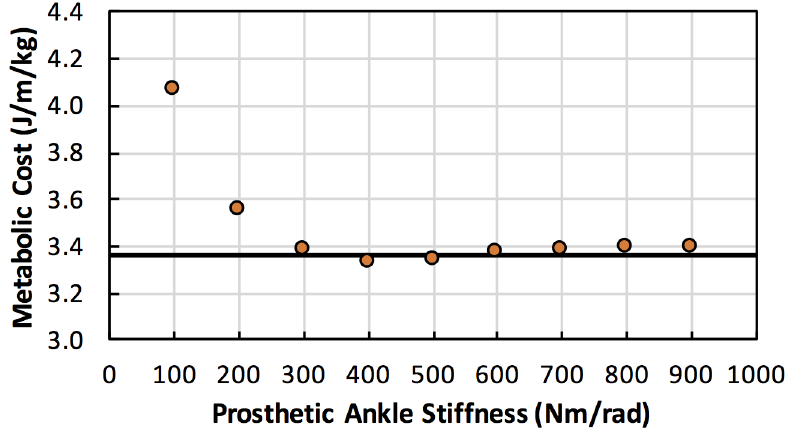
Fig 2. Prosthetic ankle stiffness vs. metabolic cost. Metabolic cost of walking at 1.3 m/s using the post-limb loss model with no strength loss and a passive prosthesis, with different prosthetic ankle stiffnesses. Horizontal line is the metabolic cost of the pre-limb loss simulation at this same